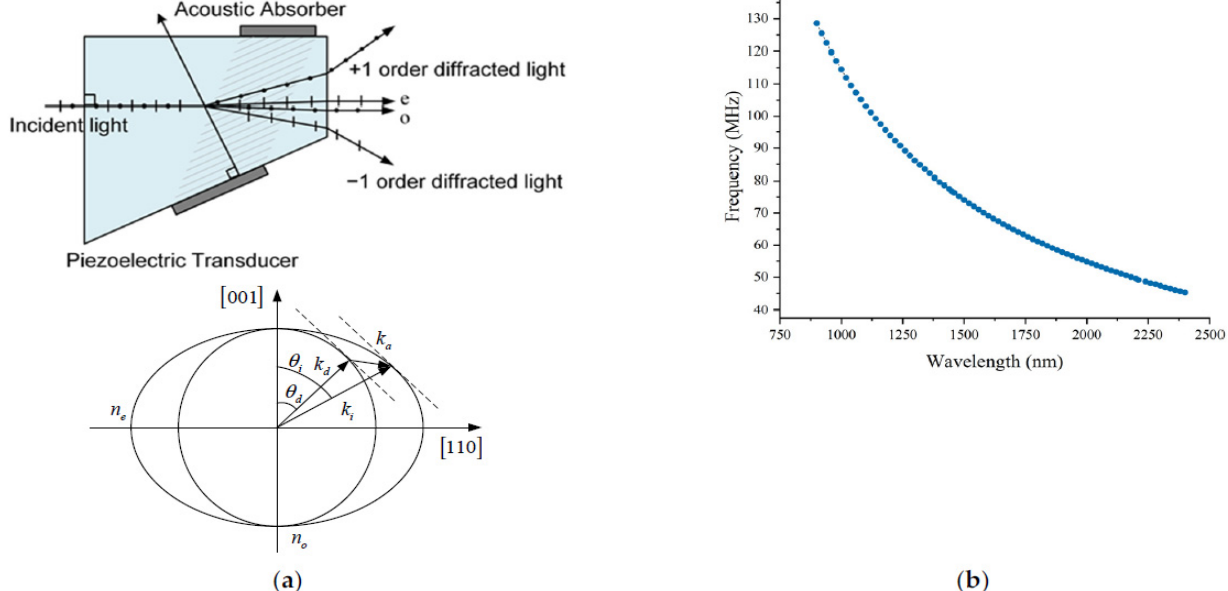
Figure 2. AOTF spectroscopy schematic. ( a ) AOTF spectroscopy and wave vector diagram; ( b ) curve of AOTF driving frequency with diffraction wavelength.